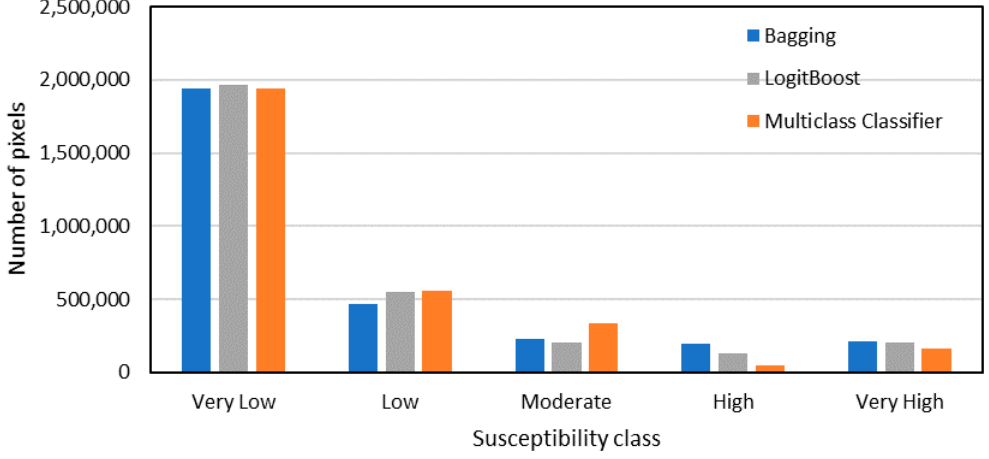
Figure 6. Distribution of pixels classified as areas of very low, low, moderate, high, and very high susceptibility in the land-subsidence-susceptibility maps generated by three machine-learning algorithms.